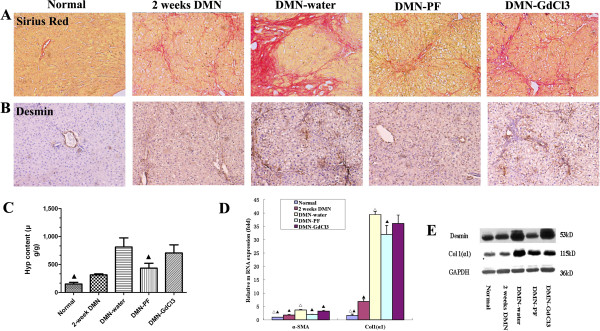
Effects of PF on histological changes.A, Sirius Red staining, ×100 magnification; B, desmin staining, brown staining indicates immunopositivity ×200 magnification, n=3; C, Hyp content; The number in Hyp and sirius red detection was the same as the number of animals in each group, data as mean ±SD, ☆p<0.05 versus 2-week DMN rats; ⋆p<0.05 versus DMN-water rats. Kruskal-Wallis test was used for group comparisons in Hyp. D, α-SMA and Col1(α1) using real-time PCR analysis, as an internal control, 18S rRNA was amplified (n=3), data as mean ±SD, ▴p<0.05 versus DMN-water rats; Δp<0.05 versus 2-week DMN rats. Bonferroni’s multiple comparison test were used for group comparisons in α-SMA and Col1(α1). E, the expression of desmin and Col1(α1) was analyzed using western blot in rat livers with DMN-induced liver fibrosis (n=3); western blotting of total protein extracts with antibodies recognizing desmin, Col1(α1), and GAPDH respectively.